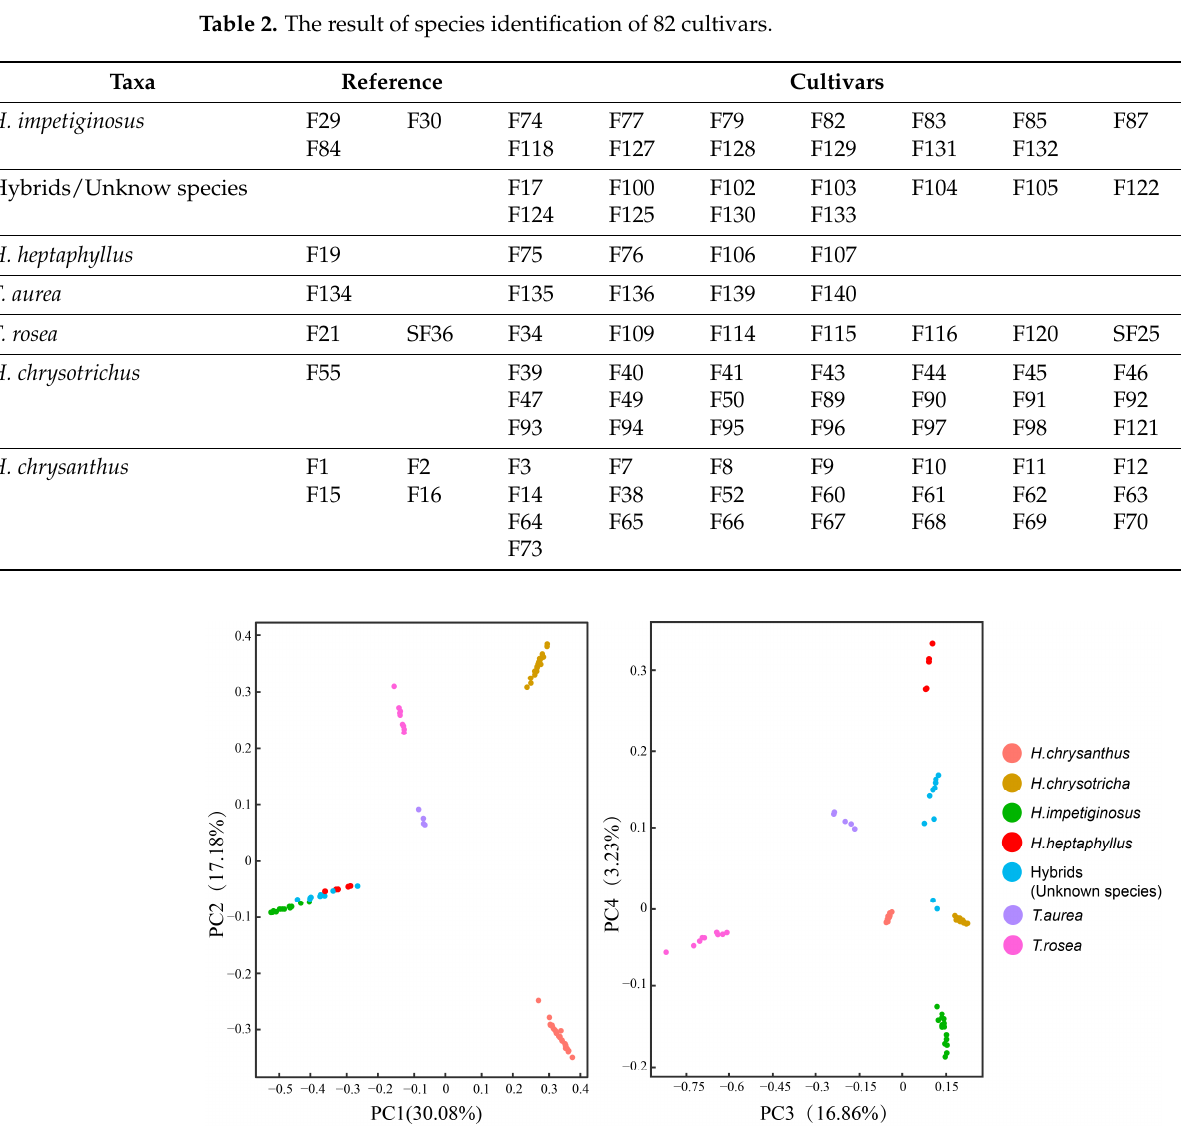
Figure 3. PCA analysis of the first four component of the 7 species/populations.